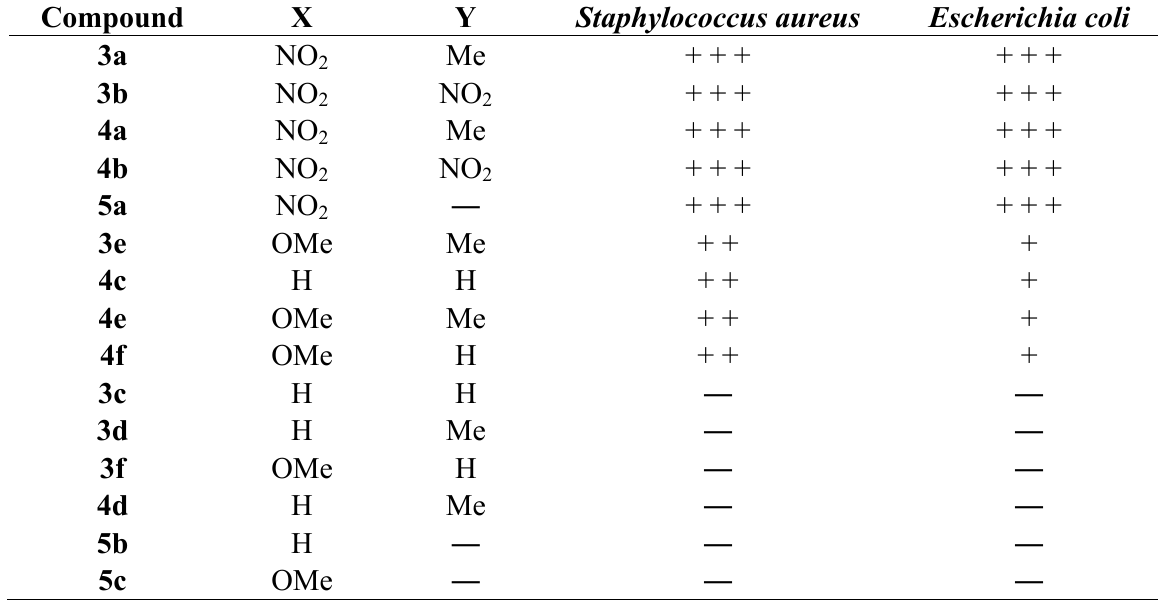
Table 3. Antibacterial activities of newly synthesized compounds 3–5